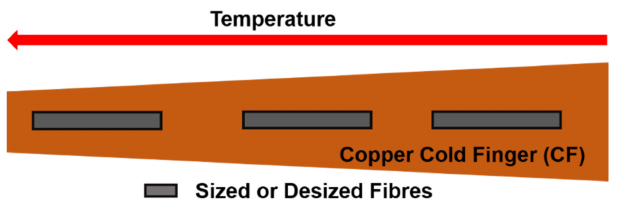
Figure 5. Schematics of the sample’s positions on the Cold Finger for moderate temperature